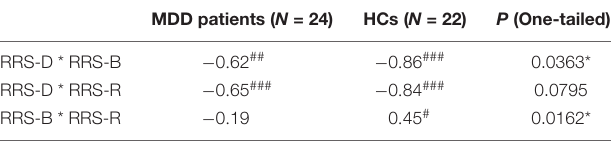
TABLE 2 | Groupwise correlation coefficients between rumination